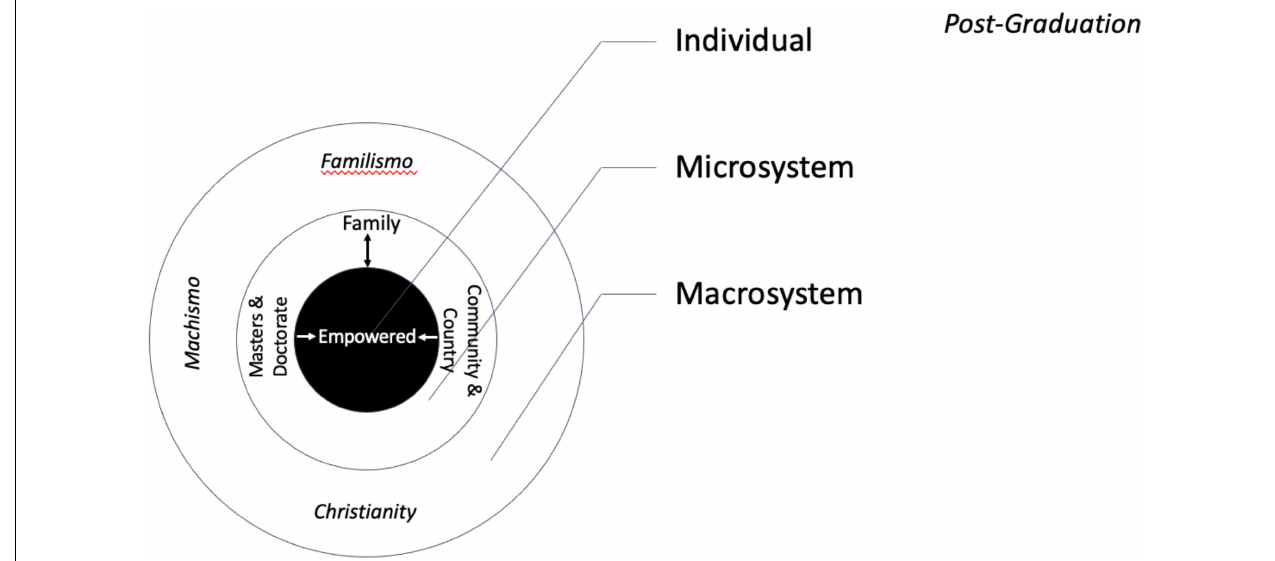
FIGURE 4 | Graphically depicts the anticipated systems of the student